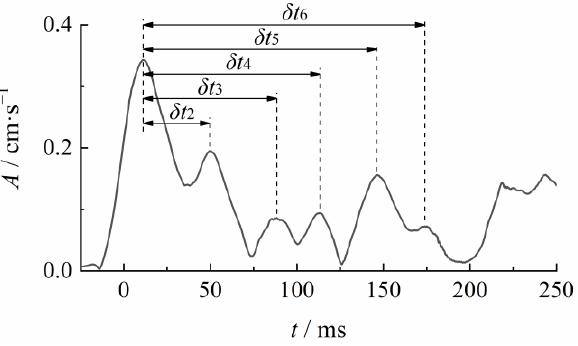
Figure 7. Envelope of the IMF3.